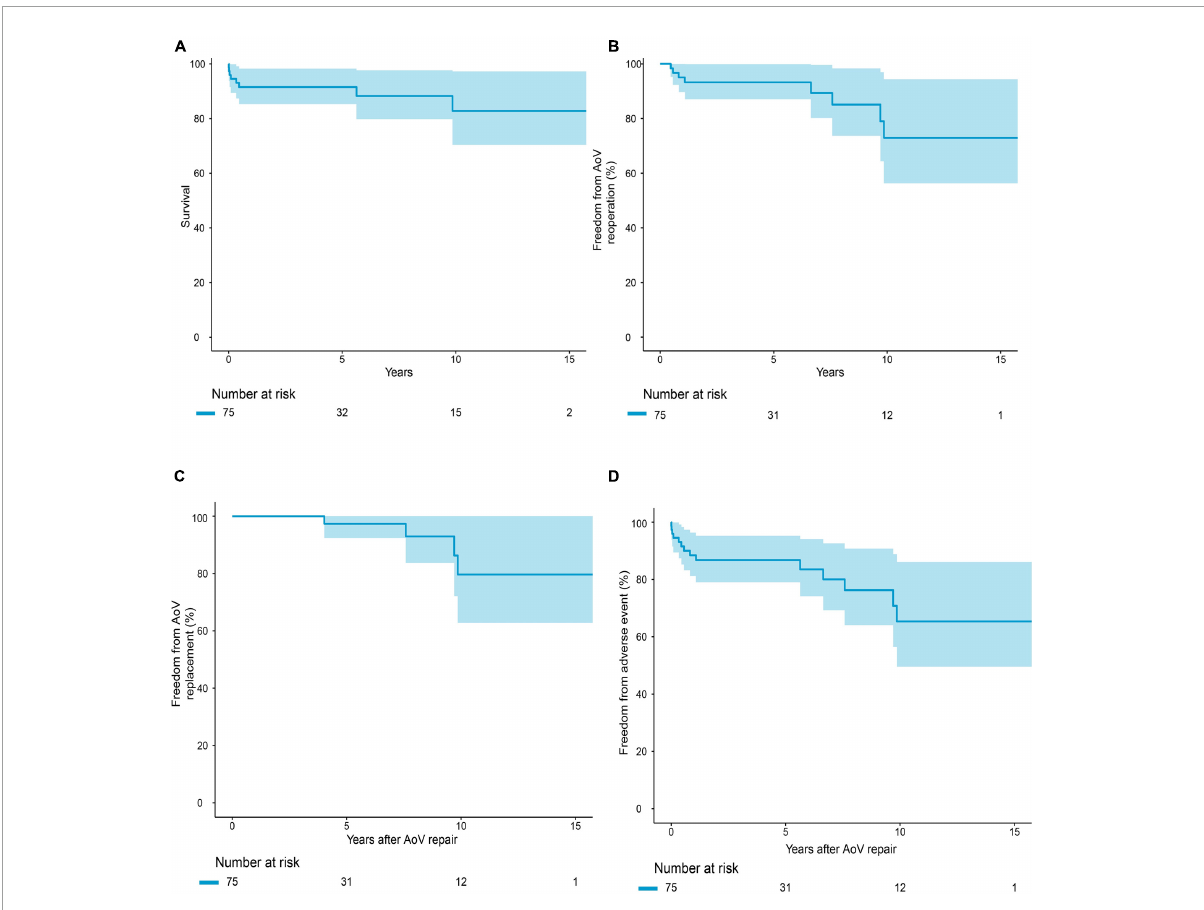
FIGURE2 Survival (A) freedom from reoperation (B) Adverse event (C) Replacement (D) for the overall